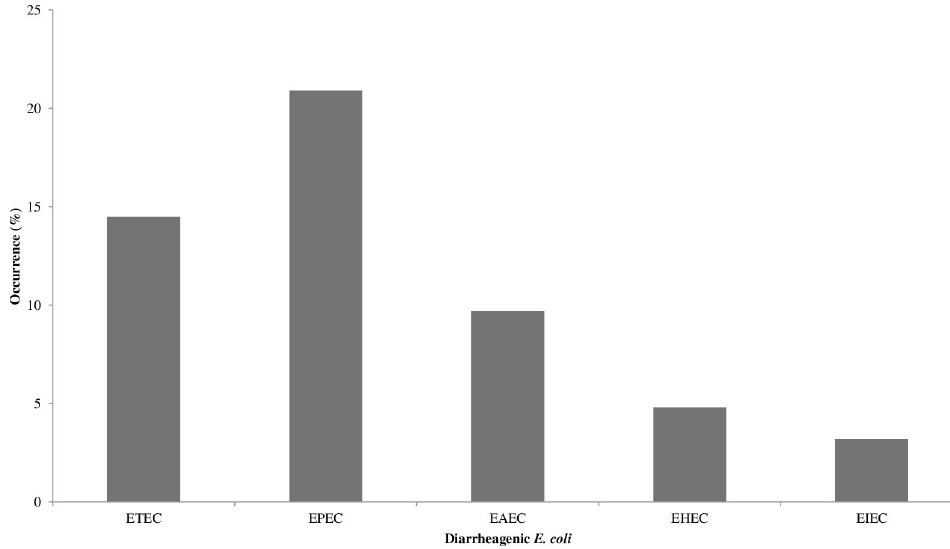
Fig 3. Typical diarrheagenic E . coli from processed RTE